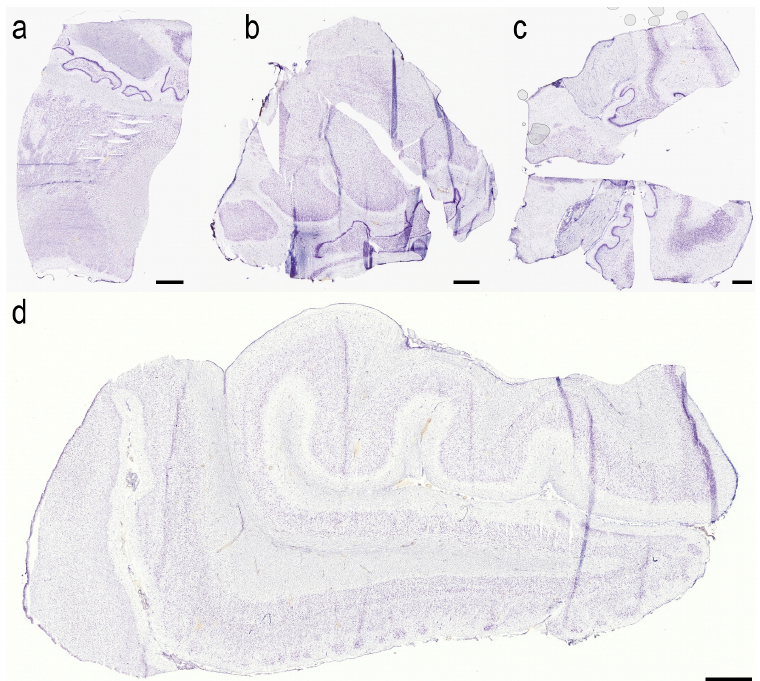
Figure A1. Examples of excluded samples. Material from non-demented donors were excluded if the hippocampal regions were not available due to distinct anatomical level or damages from the histological processing. This is illustrated by the samples from donors H14.09.081 ( a ), H14.09.028 ( b